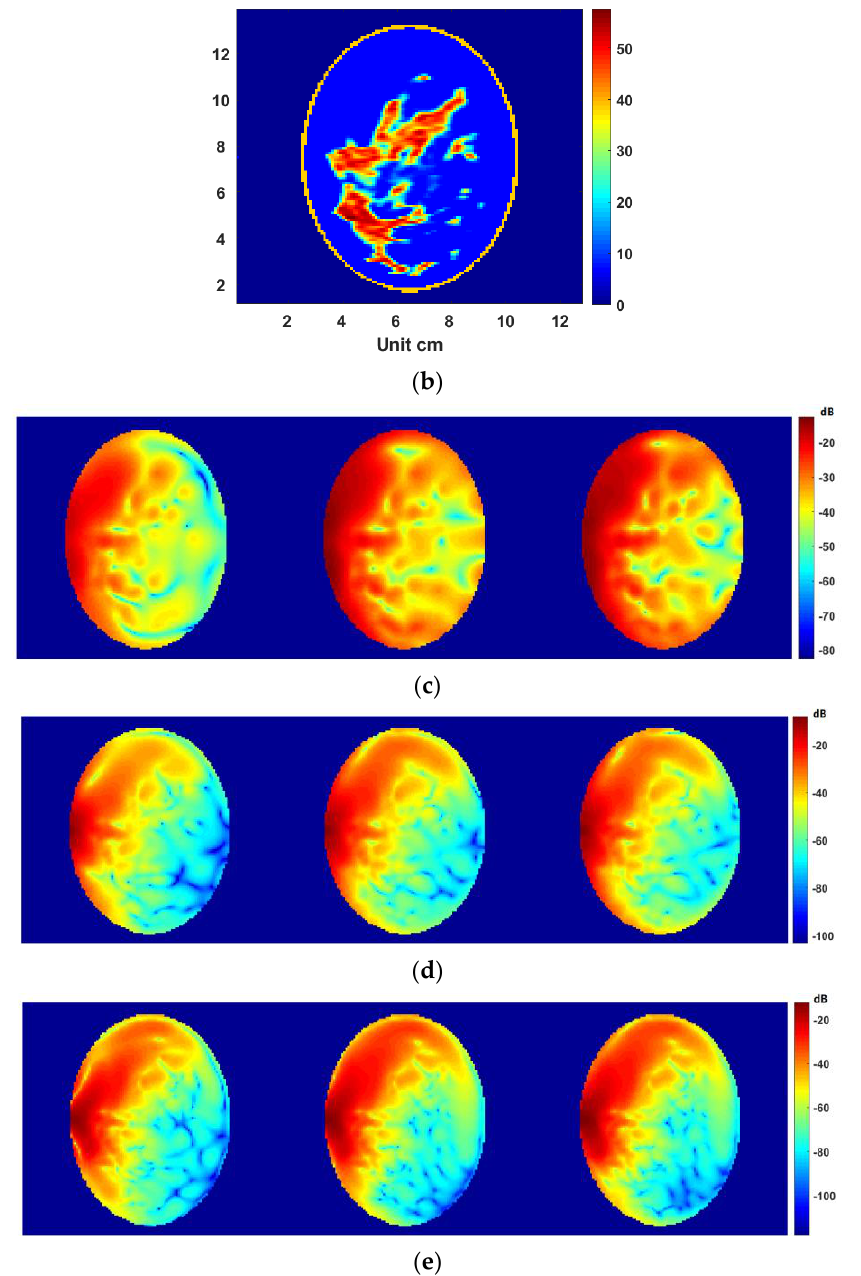
Figure 5. Electromagnetic field in a breast. ( a ) Setup of the measurement; ( b ) an extracted slice from the 3D breast model in the trans − axial plane. ( c ) From the left to right: 3 GHz field in the breast when no liquid was used (in air), field in the breast when 99% isopropyl was used, and field in the breast when glycerin was used, respectively. ( d ) From the left to right: 5 GHz field in the breast when no liquid was used (in air), field in the breast when 99% isopropyl was used, and field in the breast when glycerin was used, respectively. ( e ) From the left to right: 7 GHz field in the breast when no liquid was used (in air), field in the breast when 99% isopropyl was used, and field in the breast when glycerin was used,